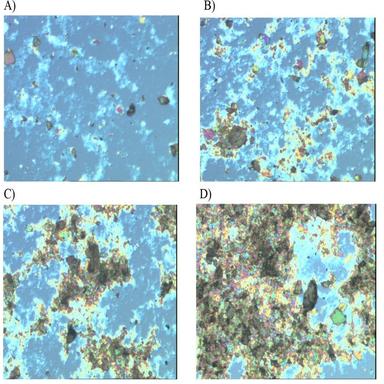
Leica optical microscope DM4000M with Sarfusoft 2.1 system images illustrating the increase of surface coverage with the number of deposited bilayers (PEI/ GO)n with the occurrence of larger connectivity of graphene oxide sheets networks (A – 1 bilayer, B – 3 bilayers, C – 5 bilayers, D – 7 bilayers).